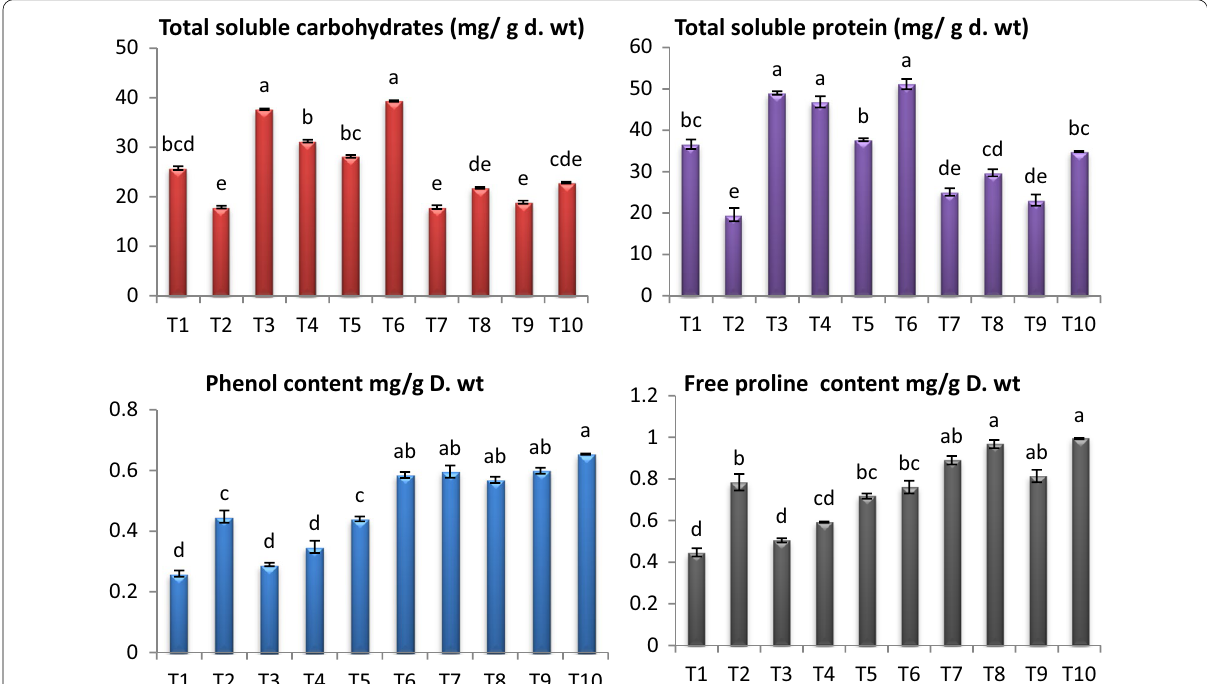
Fig. 4 Effect of F. oxysporum and endophytic isolates on osmolytes (mg/g dry weight) of tomato plants. Data presented as means followed by different letters (a:f) are significantly different LSD test at P treated with A. flavus ; T4-Healthy treated with A. nidulance ; T5-Healthy treated with A. fumigatus ; T6-Healthy treated with combination of A. flavus, A. nidulance and A. fumigatus ; T7-Infected treated with A. flavus ;T8-Infected treated with A. nidulance ; T9-Infected treated with A. fumigatus and T10-Infected treated with combination of A. flavus, A. nidulance and A. fumigatus